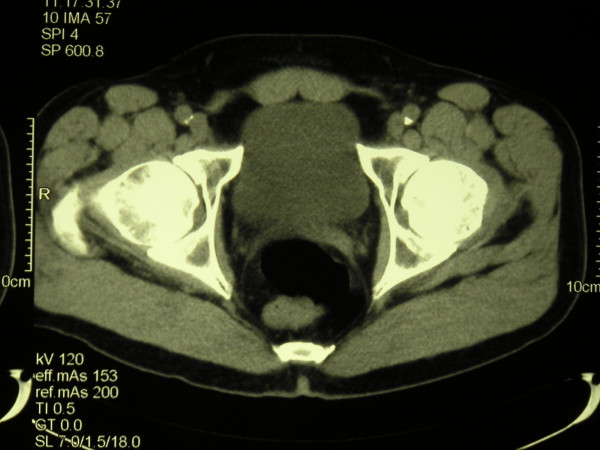
CT scan showing complete regression of pelvic metastases after chemotherapy.